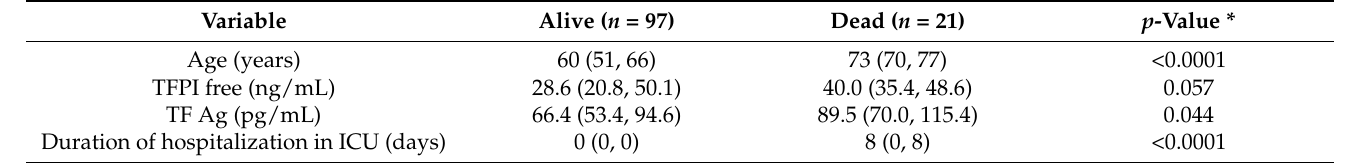
Table 4. Top four feature combination associated with mortality risk at patients with COVID-19 admitted in ICU. Continuous data are presented as medians